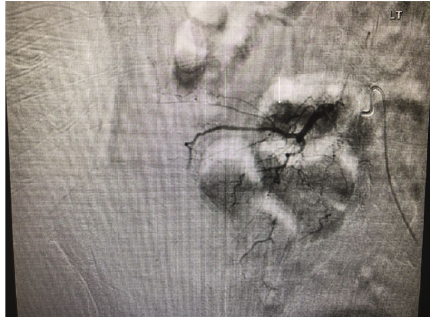
Figure 1: CT scan of the abdomen and pelvis for the fi rst patient; the white arrow points towards a site of active extravasation ( “ blush ” ).